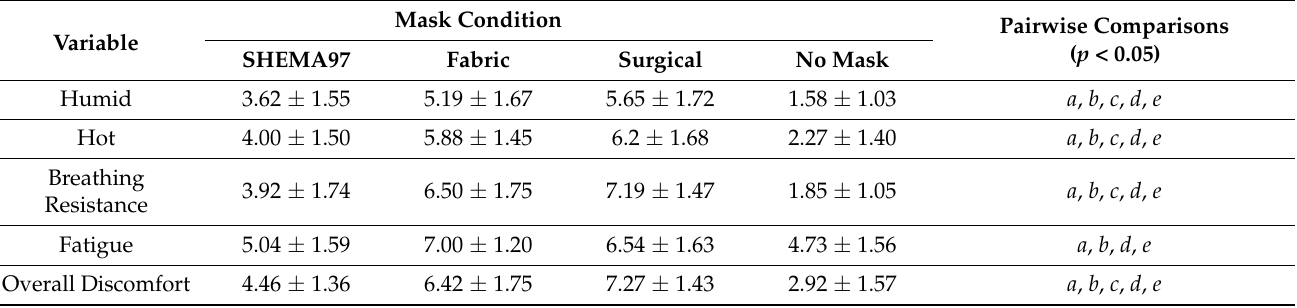
Table 3. Measures of